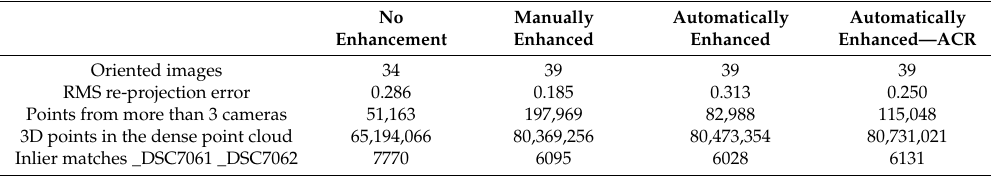
Table 3. “Palazzo Albergati” dataset—photogrammetric process results.